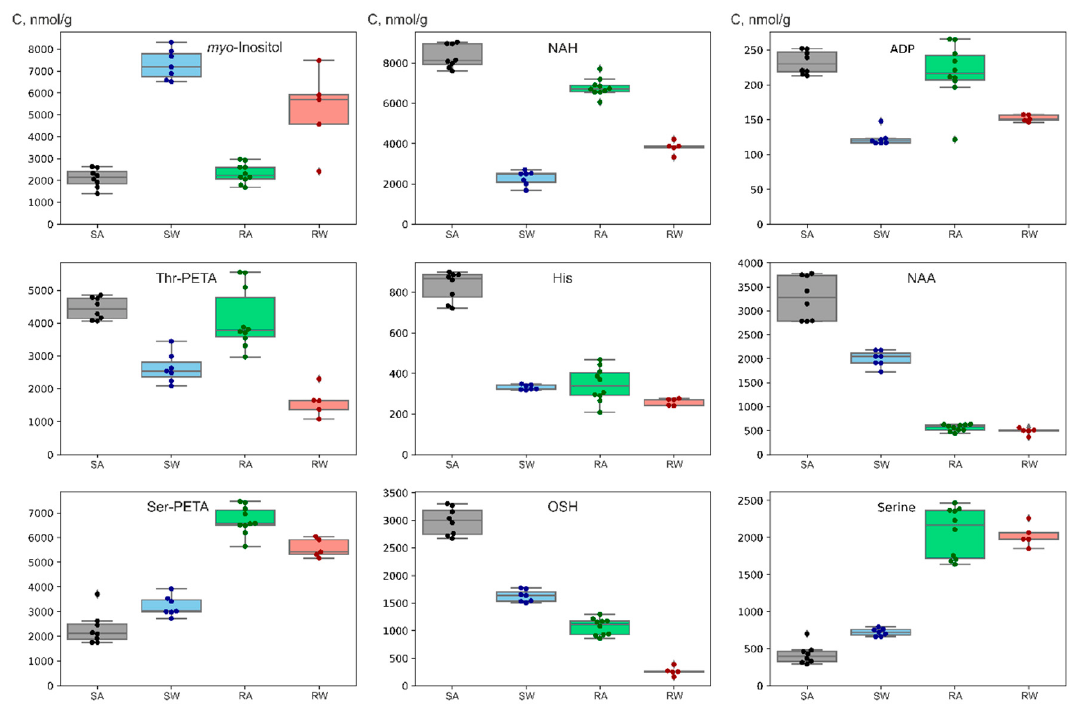
Figure 4. Boxplots for concentrations of metabolites in lenses of S. lucioperca caught in autumn (SA, black) and winter (SW, blue) periods, and R. rutilus lacustris caught in autumn (RA, green) and winter (RW, red) periods.